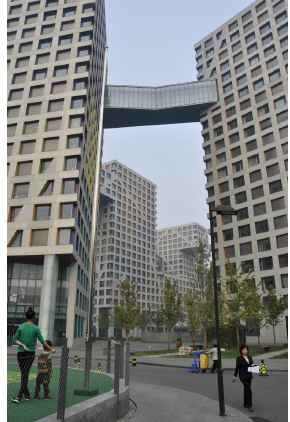
Figure 2. Linked Hybrid—Steven Holl (Courtesy Terri Boake, University of